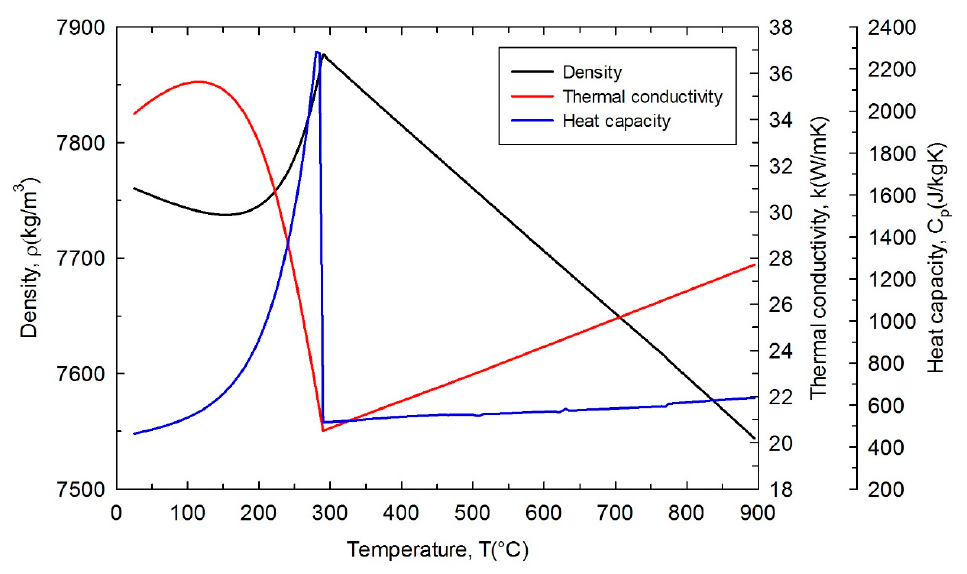
Figure 1. Thermophysical properties of steel DIN 51CrV4 estimated from JMatPro ® software for a cooling rate of 56 °C/s from austenizing to ambient temperature. Notice how properties change abruptly at temperature of martensite start, M s = 288 °C. Heat capacity considers the solid-phase transformation latent heat.